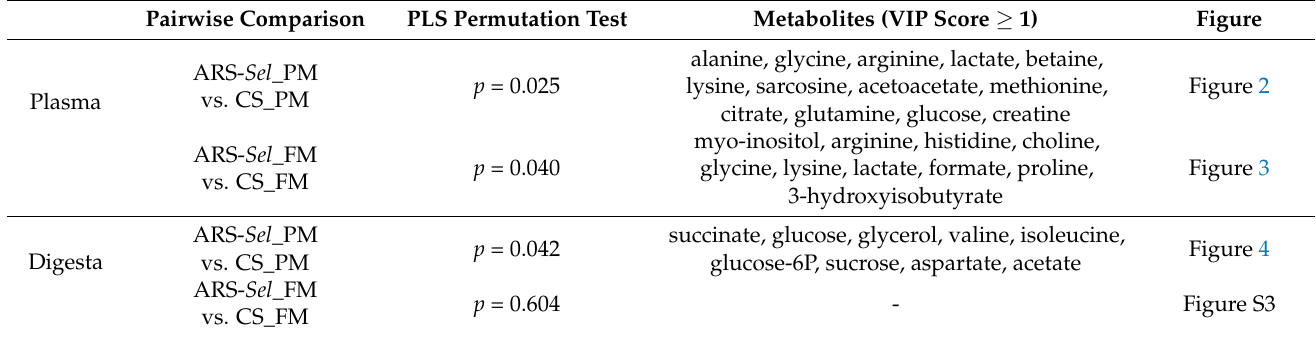
Table 2. Summary of the results of the pairwise multivariate analysis in plasma and digesta samples for fish strains subjected to the same diet: p -value of the permutation testing of the PLS models, and list of metabolites assigned as VIP (score ≥ 1). Pairwise